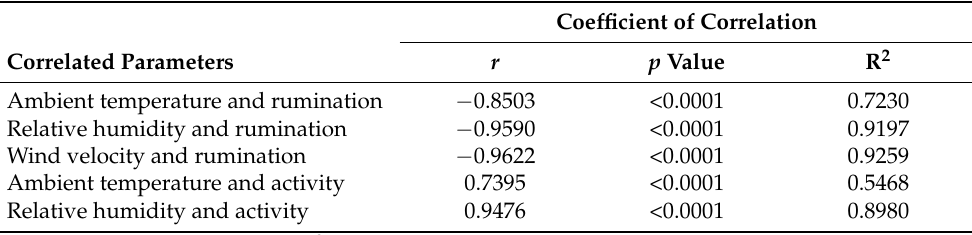
Table 4. Relationship between environmental parameters, rumination, and activity behavior in beef calves during the study